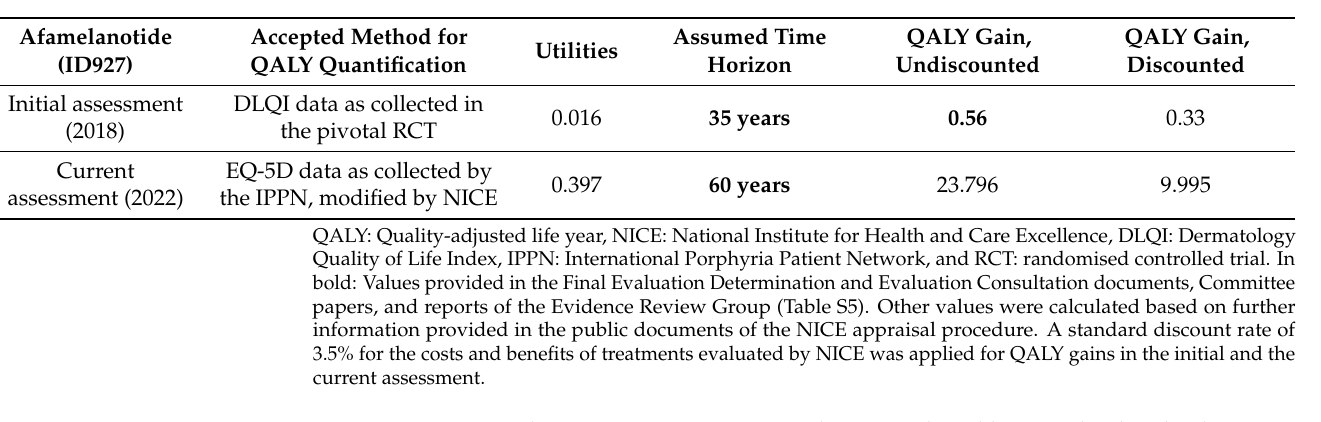
Table 2. Quantification of QALYs in the assessment of afamelanotide for treating erythropoietic protoporphyria at